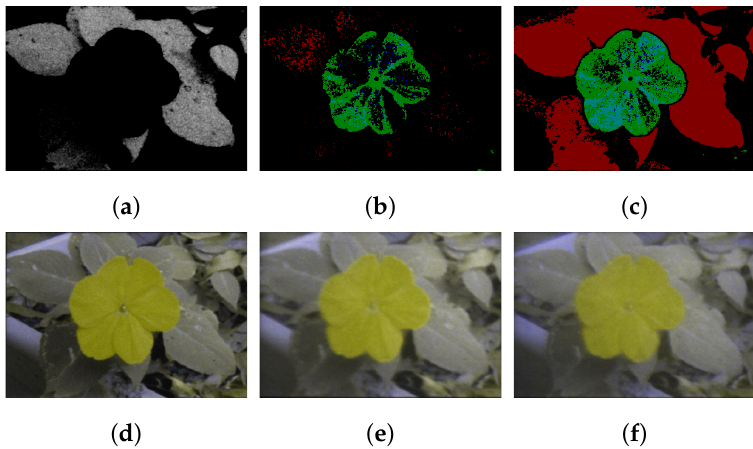
Figure 11. ( a ) Bright pixels are ones that need subtraction; ( b ) error pixels when t = 33, color stands for the corresponding color channel; ( c ) error pixels when t = 100; ( d ) simulation of I T ; ( e ) Simulation of I U when t = 33; and ( f ) Simulation of I U when t =